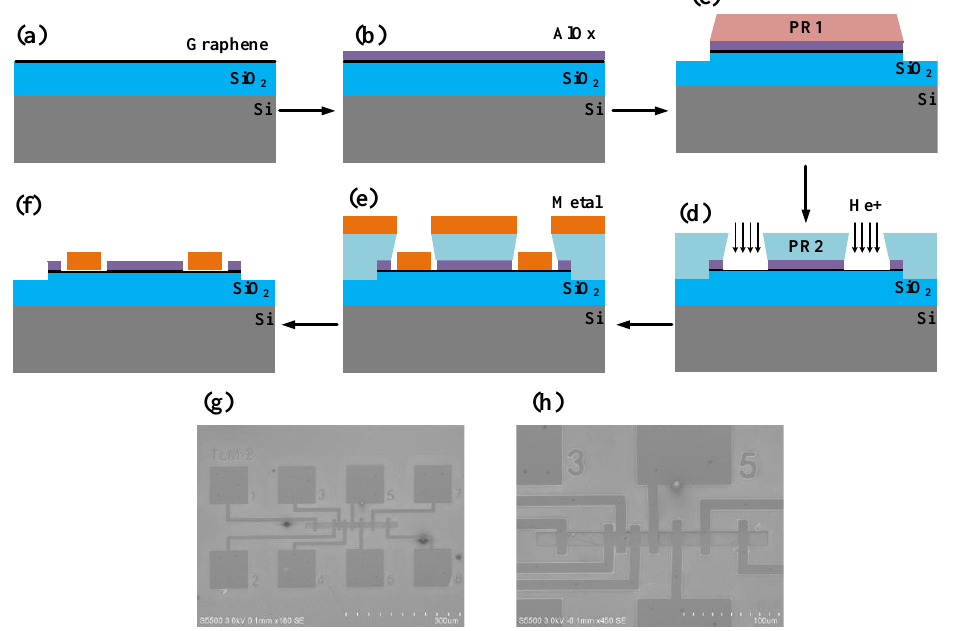
Figure 2. Schematics of the process showing the fabrication flow of transferring line method (TLM) test structures. ( a ) CVD-grown graphene is transferred onto SiO 2 /Si substrate; ( b ) The AlO x isolation